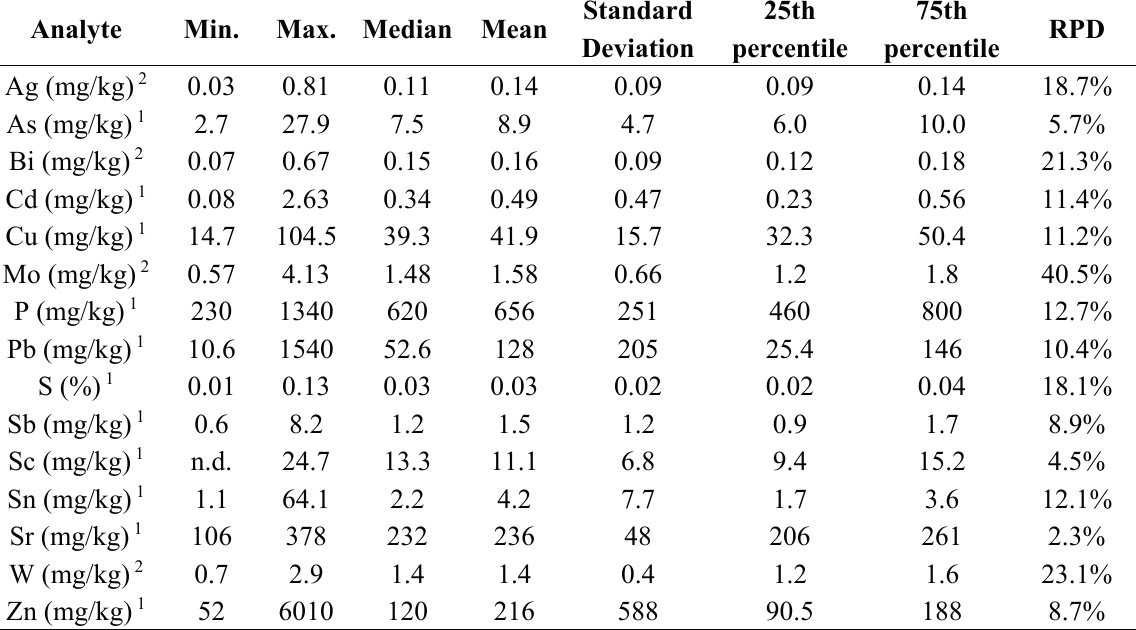
Table 1. Summary of elemental concentrations of soil samples collected in Sacramento, CA and analyzed by MEMS method (combined ICP-AES and ICP-MS). RPD = Relative Percent Differences based on 6 duplicate analyses for each analyte.